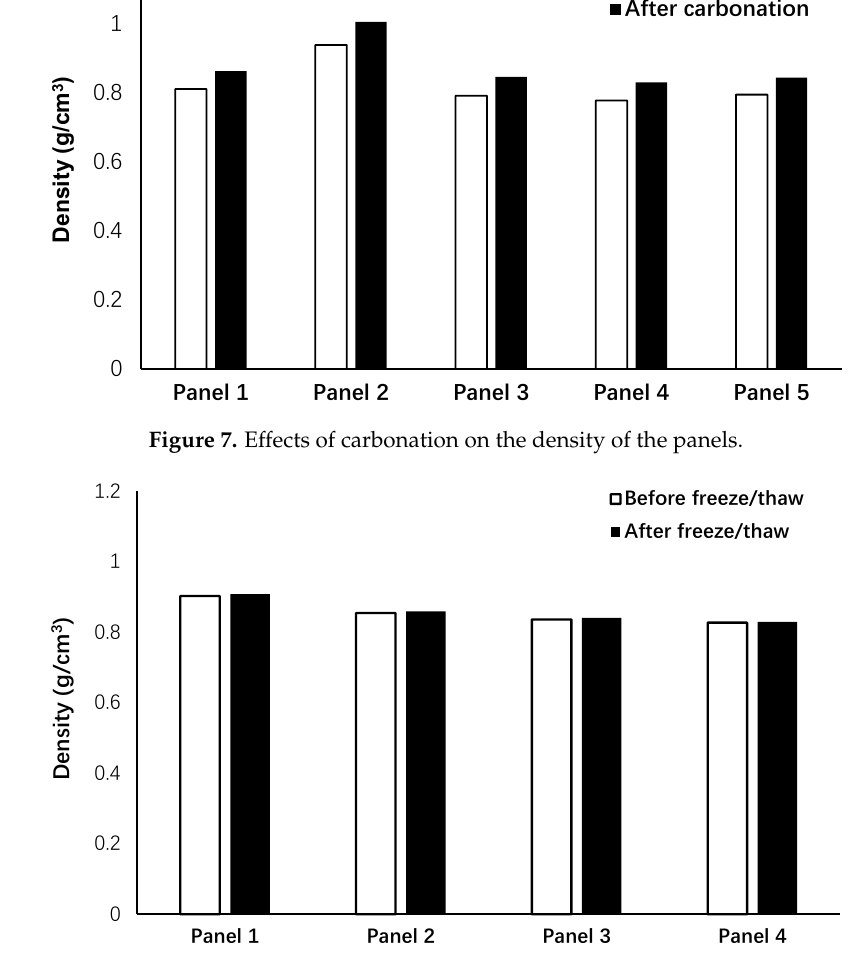
Figure 8. Effects of freeze/thaw conditions on the density of the panels.